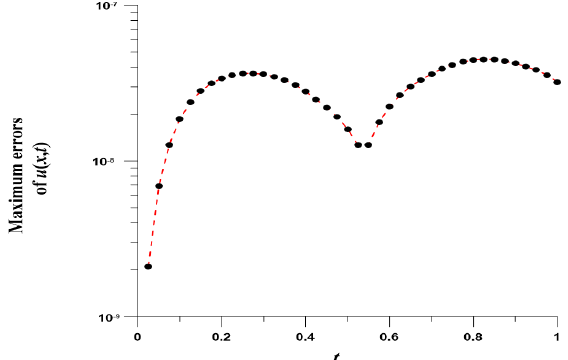
Figure 3. For Example 2: ME( u ) versus t in the time interval.